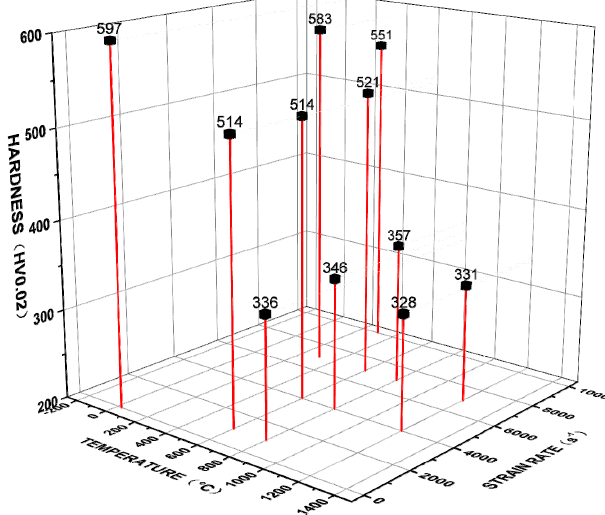
Figure 10. Microhardnesses of the SHPB tested samples.